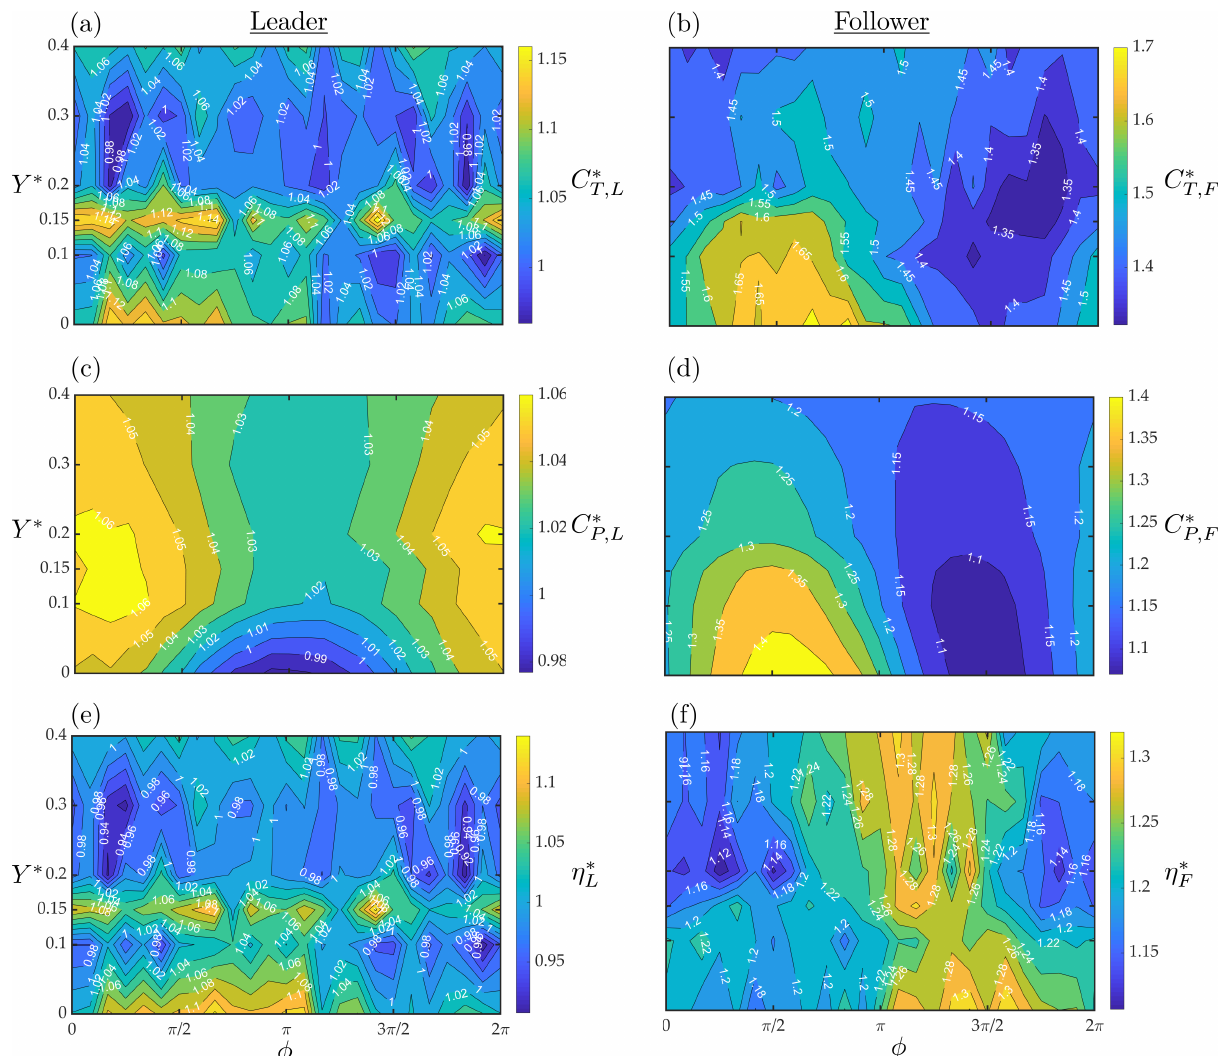
Figure A3. Normalized ( a , b ) thrust, ( c , d ) power and ( e , f ) efficiency of the leader (left column) and the follower (right column) foils in staggered arrangements for a fixed streamwise spacing of X ∗ = 0.5 as a function of synchrony and cross-stream foil